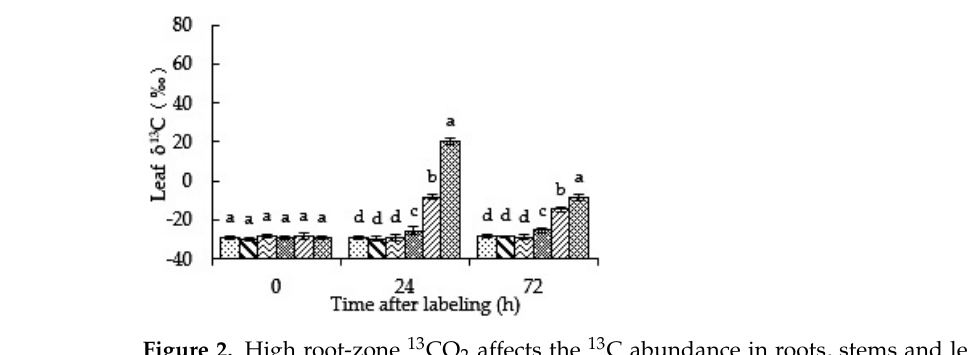
Figure 2. High root-zone 13 CO 2 affects the 13 C abundance in roots, stems and leaves of oriental melon. Standard errors (SEs) of the means are represented by error bars. Different letters in the same row indicate significance at the 0.05 level among treatments.